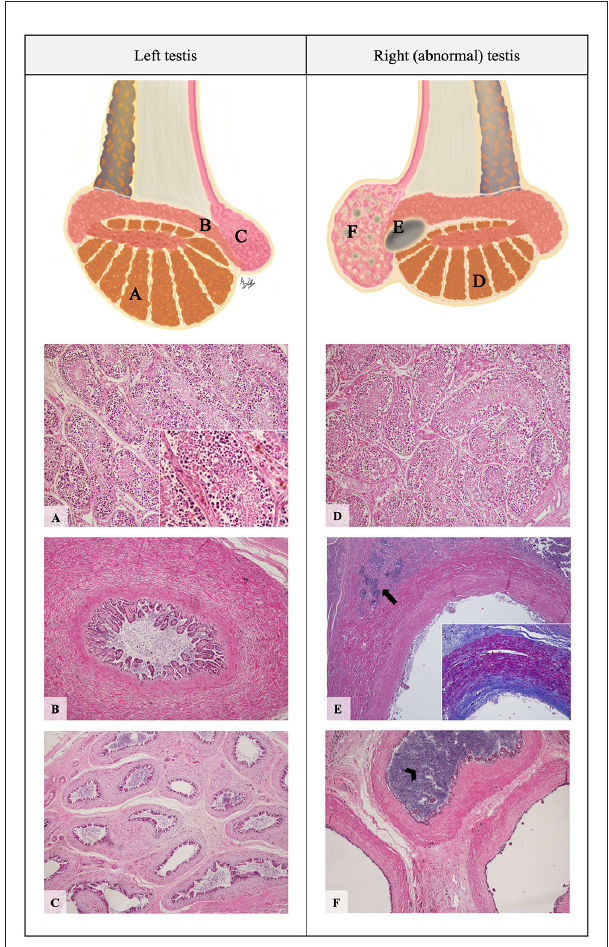
FIGURE3 Schematic representation and histopathological photomicrographic of the stallion’s testes. Left testis: parenchyma (A) , epididymal body (B) and epididymal tail (C) . Right testis: parenchyma (D) , epididymal cyst (E) and epididymal tail (F) . (A, D) Seminiferous ducts surrounded by germinal epithelium containing a large amount of exfoliated germ cells and round bodies in the lumen (H&E, 100x); Inset: Presence of spermatocytes, spermatids, and some spermatozoa in the lumen of the ducts (H&E, 400x). (B) Normal epididymal body (H&E, 40x). (E) Dilated cavity containing spermatozoa in the lumen, associated with foci of granulomatous reaction- spermatic granuloma (arrow) (H&E, 40x); Inset: The lesion is circumscribed by fibrosis and a dense muscular layer, evidenced by Masson’s Trichrome histochemical staining (40x). (F) Enlarged ducts in the tail of the epididymis, compared to those of the normal contralateral testis; Note the sperm stasis in some ducts which are filled with sperm (arrowhead) (H&E, 40x).